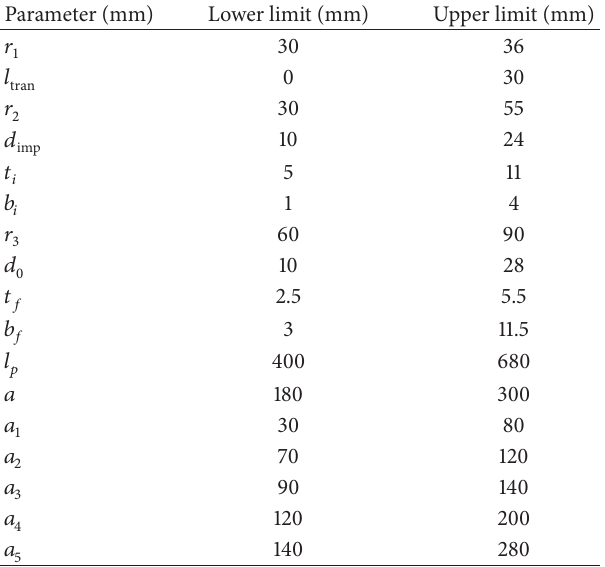
Table 1: Dimensions